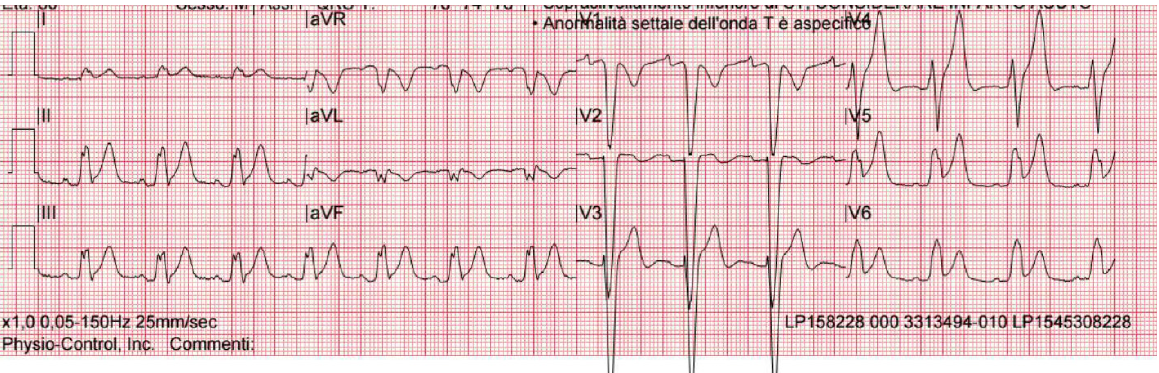
Figure 1. First EKG recorded by 118 (markedly agitated patient), sinus rhythm, left bundle branch block, inferolateral subepicardial lesion.